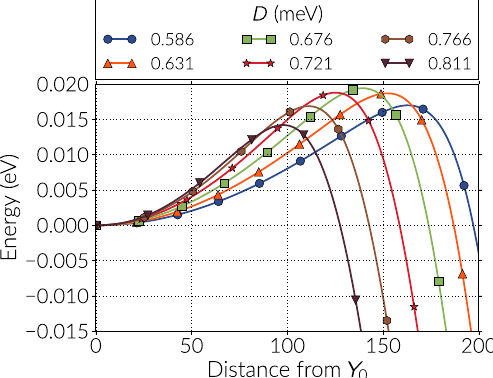
Figure 4. Energy bands for the skyrmion annihilation at the boundary. The bands are shown for different DMI constant D and only for the first few images of the bands. The first or extreme left image is the skyrmion configuration and, for every case, the energy is redefined with respect to the skyrmion energy. The continuous line is a cubic polynomial interpolation.